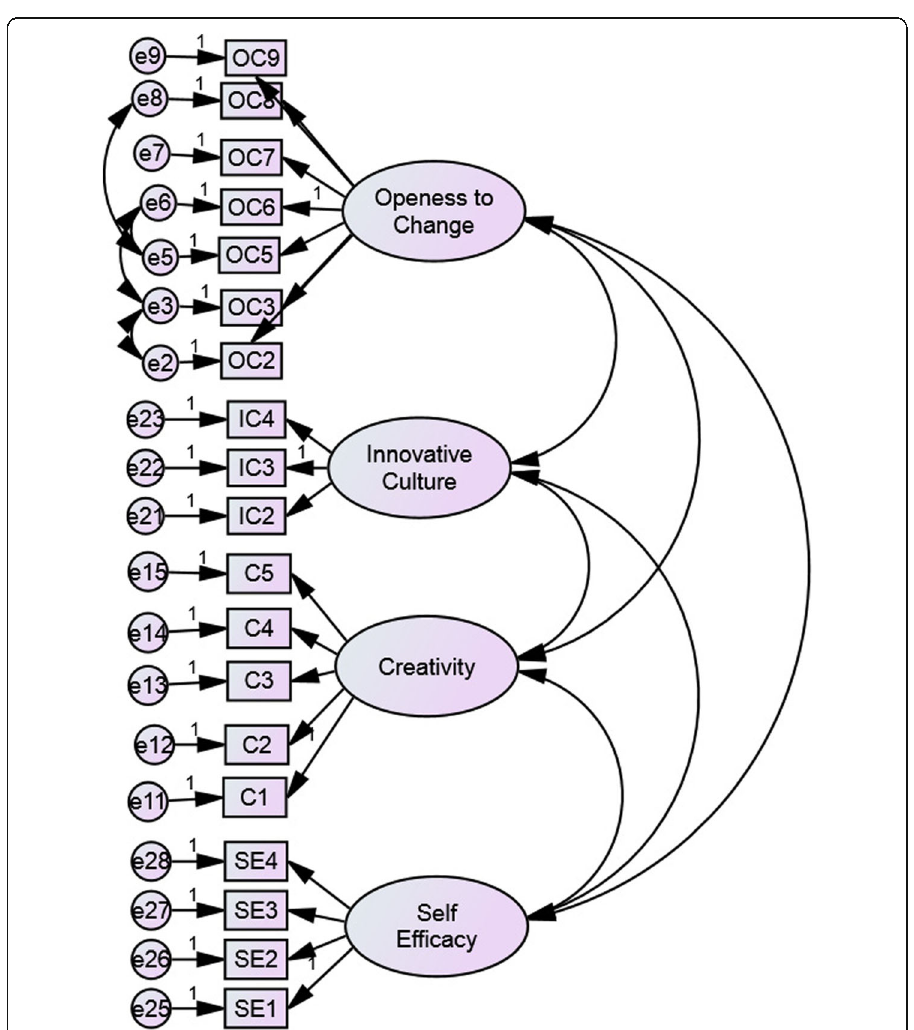
Fig. 3 Measurement m